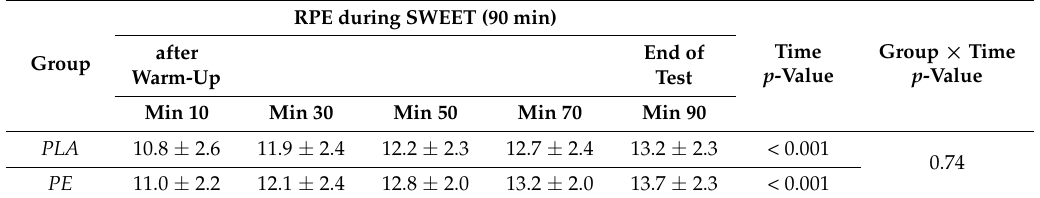
Table 2. Rate of perceived exertion (RPE) during the SWEET test. Borg scale (20-number scale), the lowest value corresponds to the lowest effort perceived and the highest to maximal perceived effort.